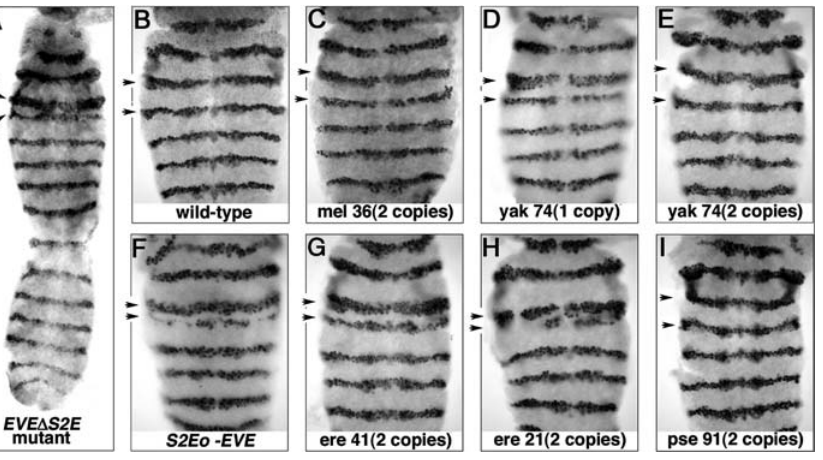
Figure 5. Effects on en Expression (A, C–I) The en pattern in homozygous EVE D S2E and (B) wild-type (w1118) specimens at stages 9–11. All strains (except [B]) are homozygous for Df(eve) P(EVE D S2E) second chromosomes, with the third chromosome differing only by rescue transgenes: (A) no rescue transgenes; (C) P(mel 36)/ P(mel 36) is a S2E mel -EVE stock; (D) P(yak 74)/TM3 Sb and (E) P(yak 74)/P(yak 74) are S2E yak -EVE stocks; (F) P(S2E o -EVE)/P(S2E o -EVE) has no S2E; both (G) P(ere 41)/P(ere 41) and (H) P(ere 21)/P(ere 21) are S2E ere -EVE transgenic stocks; and (I) P(pse 91)/P(pse 91) is a S2E pse -EVE stock. Note the variation in distance between third and forth en stripes (arrows) and relative level of en expression in the fourth stripe. Only the first seven parasegments of the en pattern are show (except in [A]). The en protein was visualized by an immunoperoxidase DAB reaction enhanced by nickel. mel: D. melanogaster; yak: D. yakuba; ere: D. erecta; pse: D. pseudoobscura. S2E o -EVE lacks a S2E . DOI: 10.1371/journal.pbio.0030093.g005